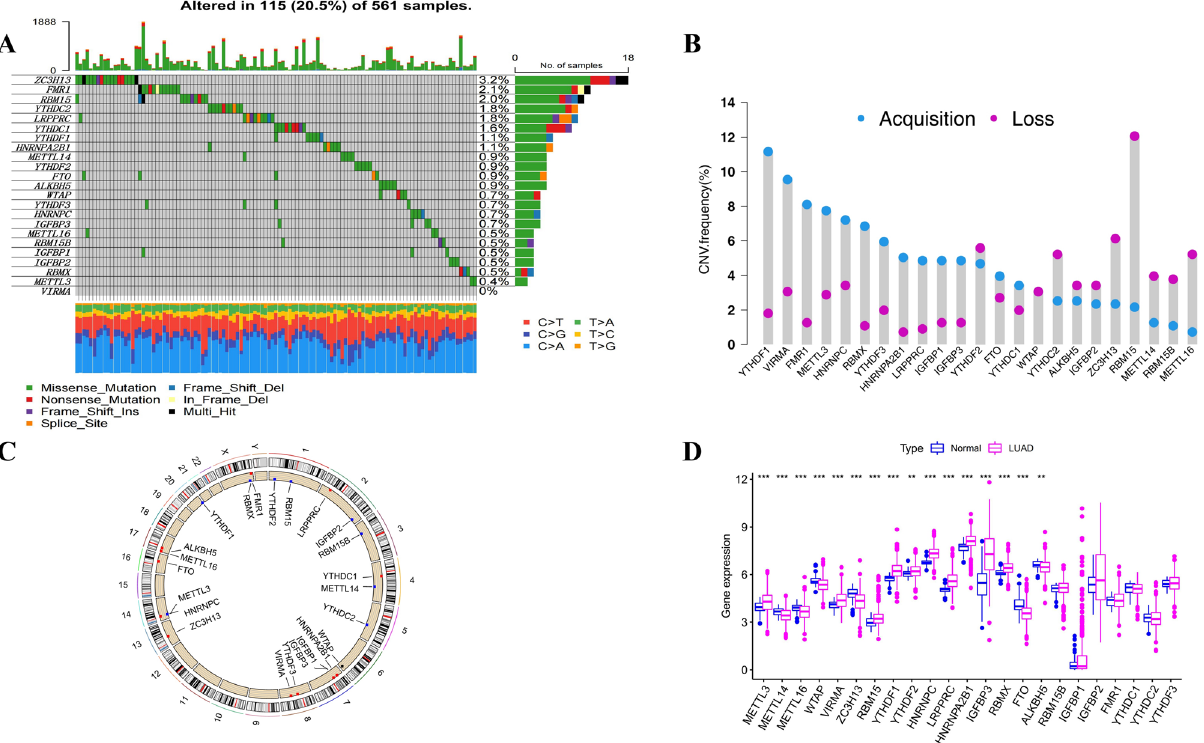
Figure 1. Genetic variation of m 6 A regulators in LUAD. ( A ) Genetic alteration for the queried m 6 A regulators. ( B ) Frequency of CNVs in m 6 A regulators. Blue dots represent CNV amplification; purple dots represent CNV deletion. ( C ) The location of the CNV alteration of the m 6 A regulators changes on 23 chromosomes in the TCGA-LUAD cohort. Red square represent more samples with increased copy number of the gene. Blue square represent more samples with missing copy number of the gene. ( D ) Comparison of gene expression of 23 m 6 A regulators in LUAD with normal tissue (* P < 0.05; ** P < 0.01; *** P < 0.001). LUAD : Lung